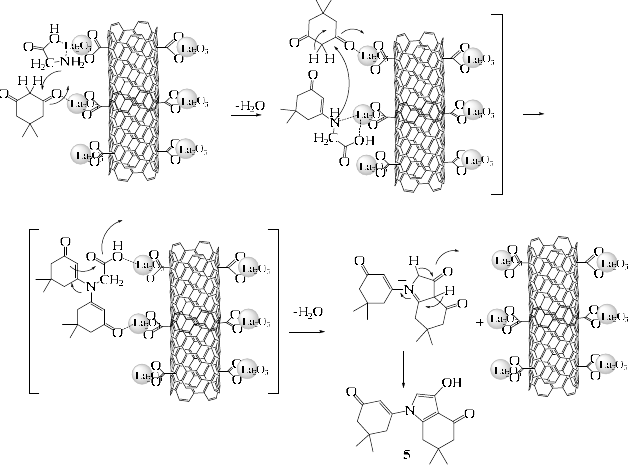
Table 3. A comparison of different catalysts for the synthesis of compound 5 in ethanol